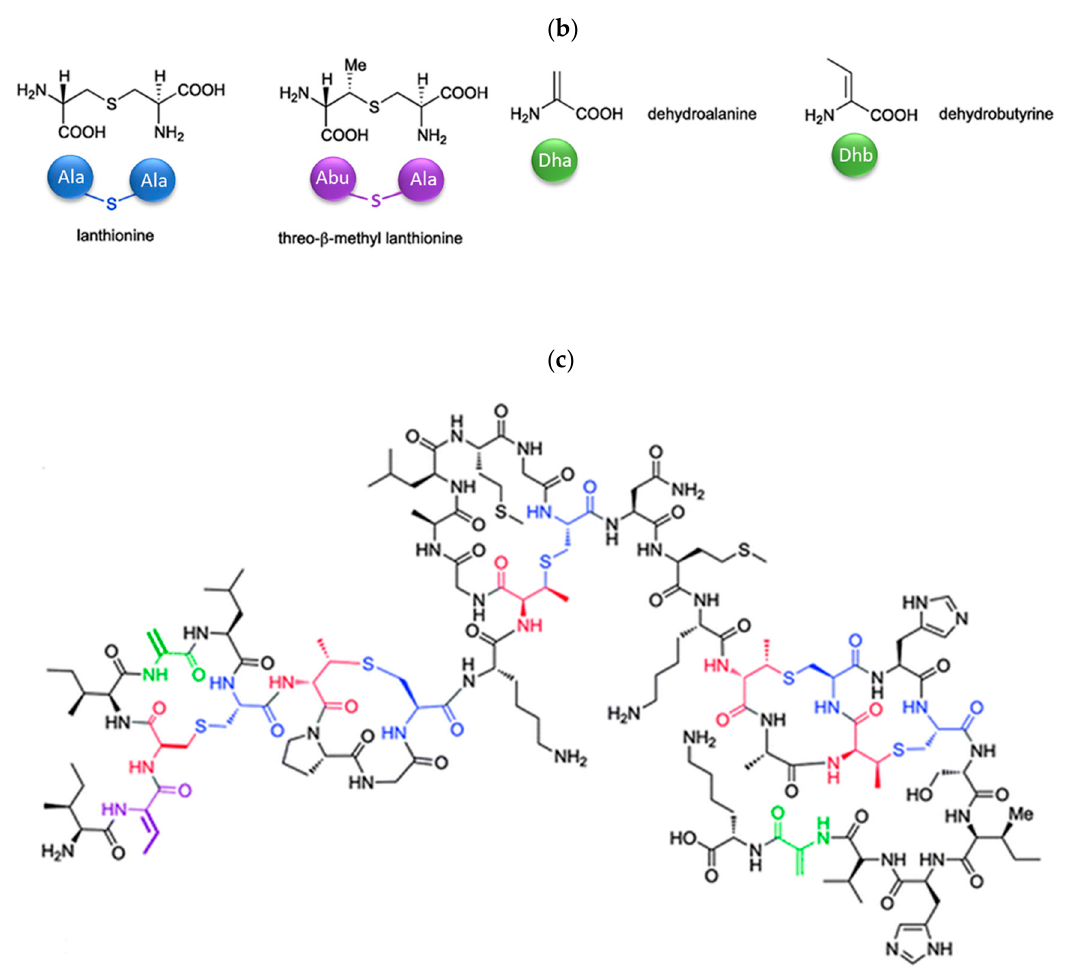
Figure 9. ( a ) Primary structure of nisin Z with highlighted residues involved in crucial aspects of the antimicrobial activity (Adapted with permission from [145], Elsevier, Amsterdam, The Netherlands, 2018); ( b ) chemical formula of dehydroalanine (Dha), dehydrobutyrine (Dhb), lanthionine (Lan), and β -methyl lanthionine (MeLan) (Adapted with permission from [145], Elsevier, Amsterdam, The Netherlands, 2018); ( c ) chemical structure of nisin A (Reproduced with permission from [146], RSC, Cambridge, UK, 2012).